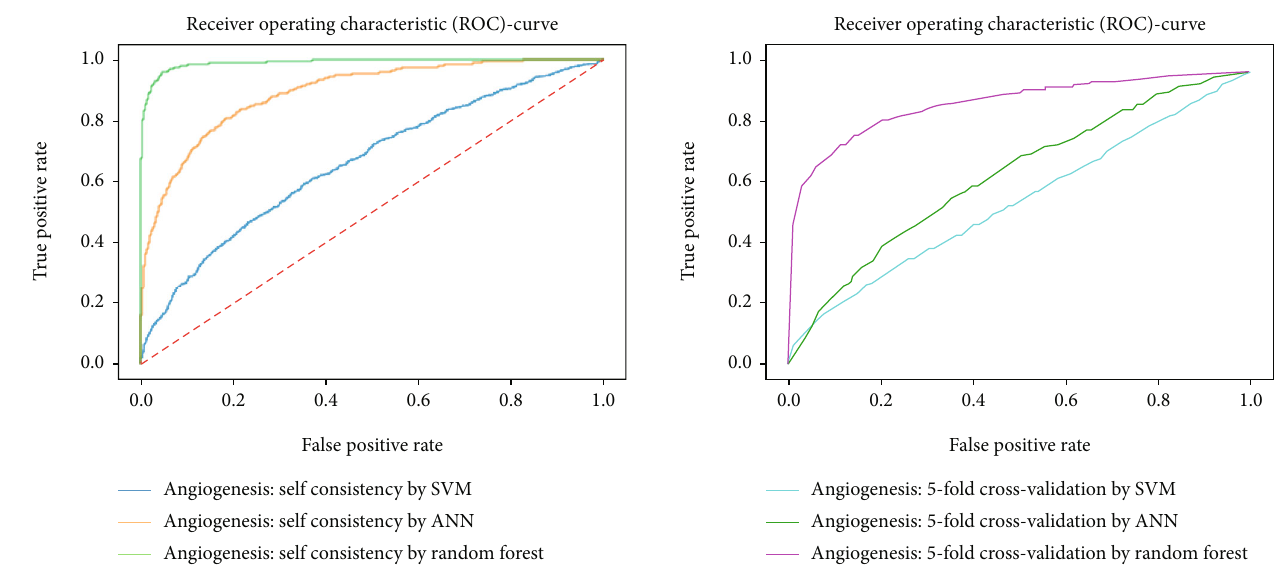
Figure 6: Comparison based on self-consistency. Figure 7: Comparison through